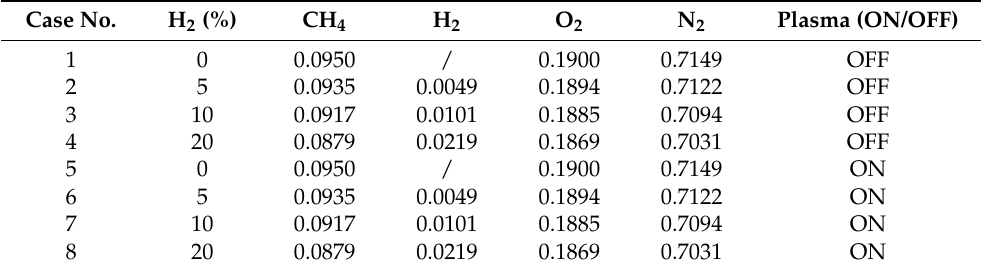
Table 1. Reactants mole fraction of CH 4 /H 2 /Air flames at plasma on and off conditions. Case No. H 2 (%) CH